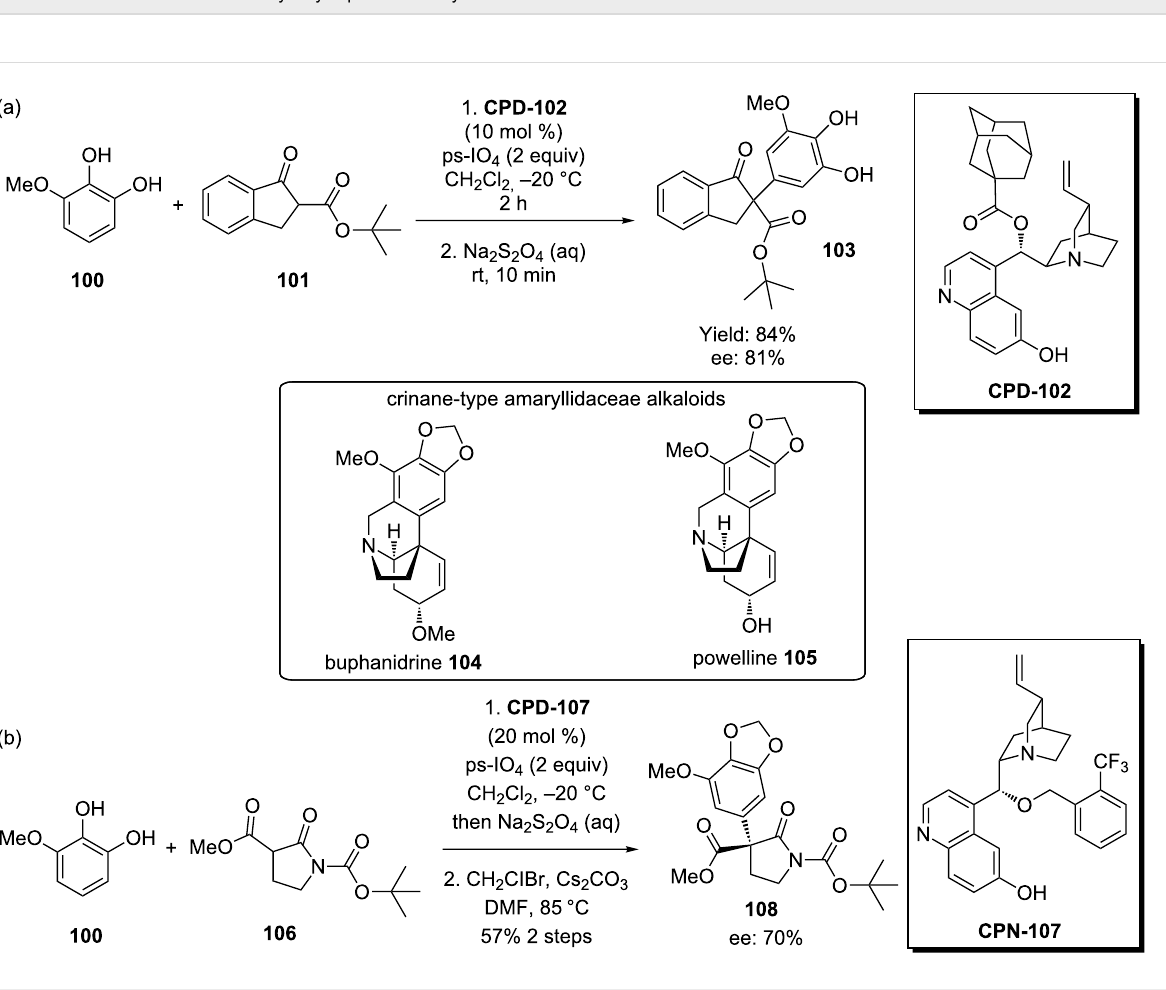
Scheme 23: A domino reaction catalyst by cupreidine catalyst CPD-30